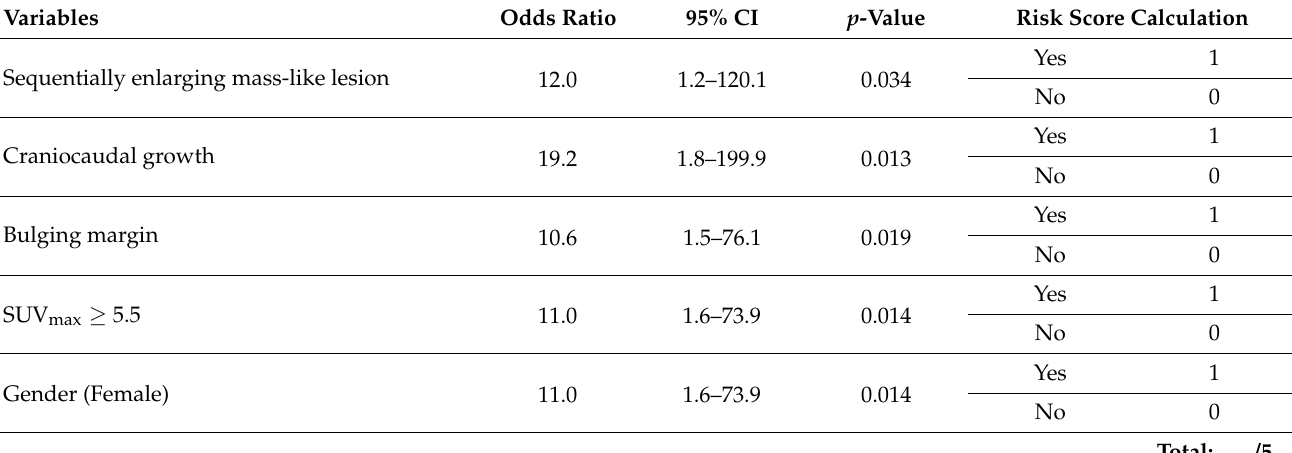
Figure 3. Example of local relapse in a female patient with score at 3. ( A , B ) show a lingular mass on axial chest CT and sagittal merge PET and CT, diagnosed after sampling as an adenocarcinoma, with hypermetabolism quantified as SUVmax = 8.0. ( C ) shows the scar 1 year after the treatment, and ( D , E ) show a local recurrence 2 years after radiation therapy. Table 2. Variables significantly associated with local recurrence and risk score calculation.